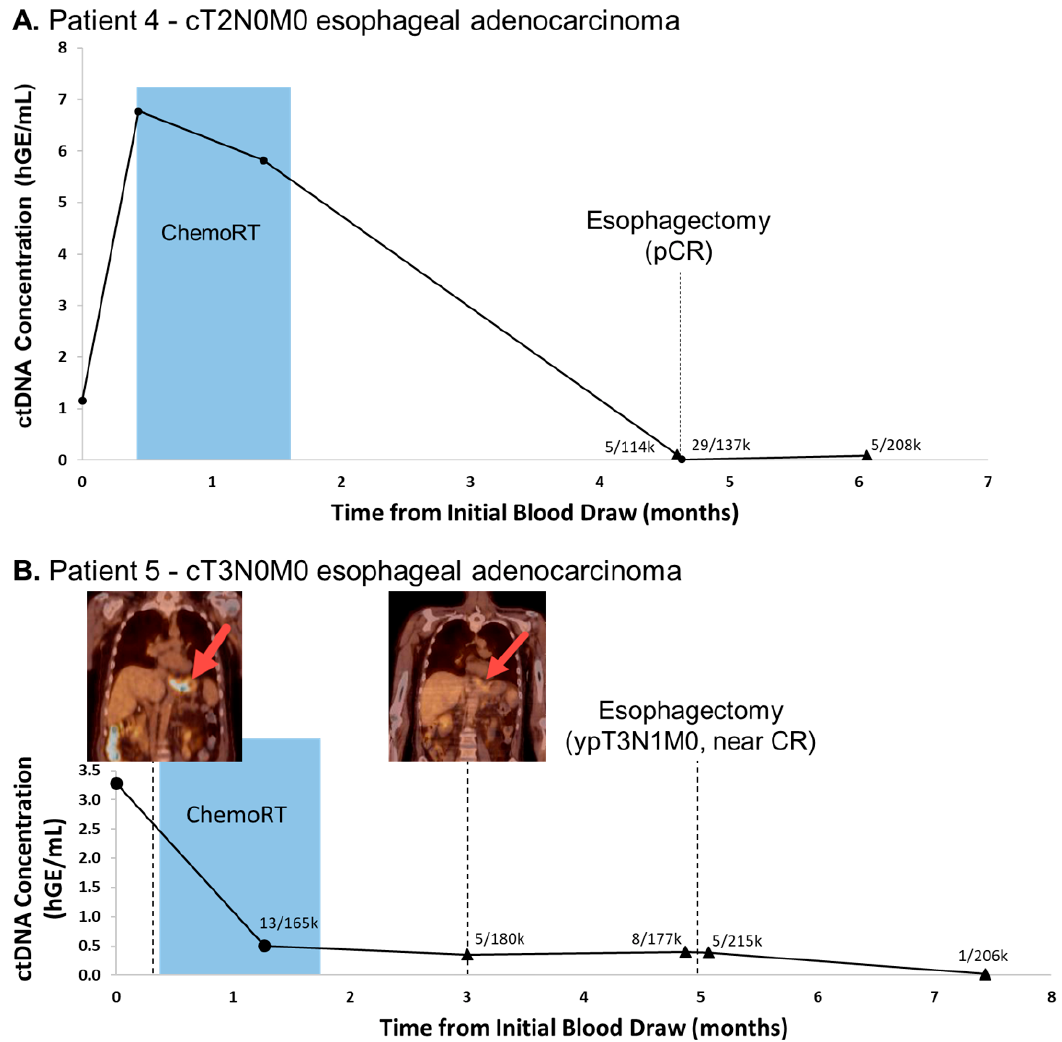
Figure 4. Esophageal adenocarcinoma cancer patients had significant declines in ctDNA during and following neoadju- vant chemoradiation. Patient 4 ( A ) had surgical confirmation of pathologic complete response (pCR) and Patient 5 ( B )